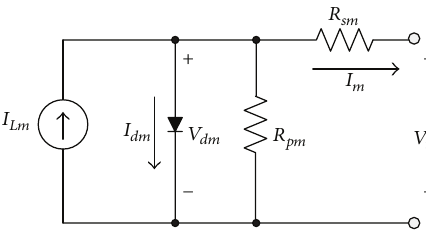
Figure 1: Equivalent circuit of PV module.